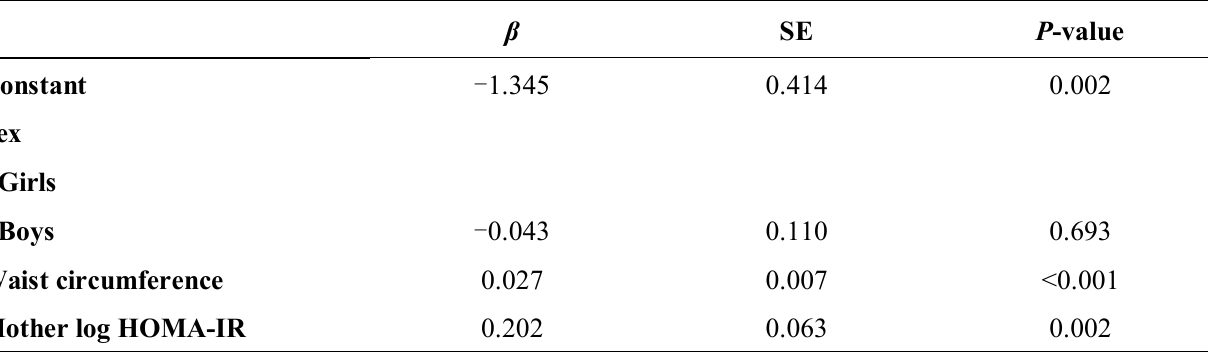
Table 5. Results of multiple regression analysis on log